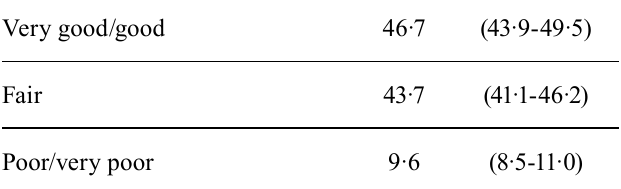
*Percentages adjusted by sample weights and post- stratification according to age and